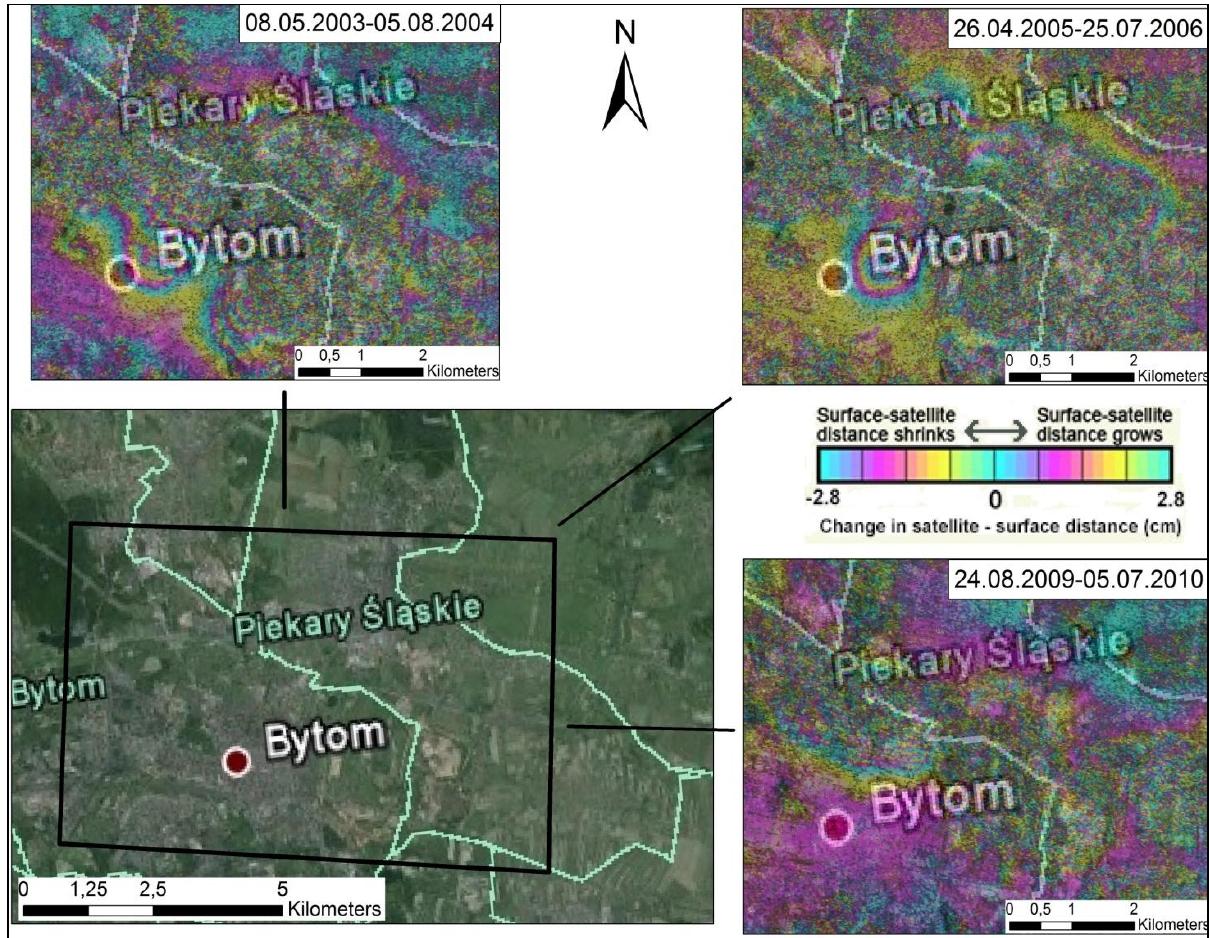
Fig. 2. Well developed subsidence under Bytom city, despite large Btemp ~in a year time range. Used images Envisat ASAR,